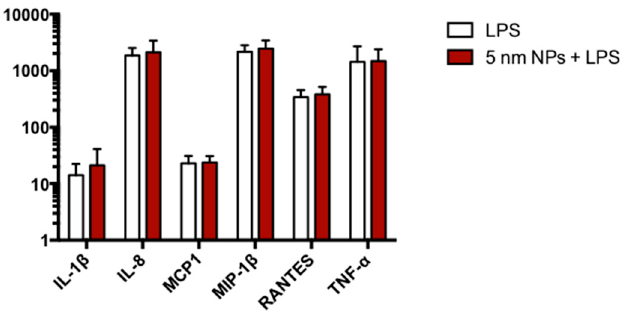
Figure 7. Cytokine release after LPS exposure. Column graphs show IL-1 β , IL-8, MCP-1, MIP-1 β , RANTES and TNF- α levels released by THP-1 after LPS exposure. The cells were treated for 6 h with 50 μ g/mL 5 nm PtNPs, then washed and exposed to 100 ng/mL LPS for 24 h. LPS columns (empty columns) represent untreated THP-1 cells stimulated with LPS.